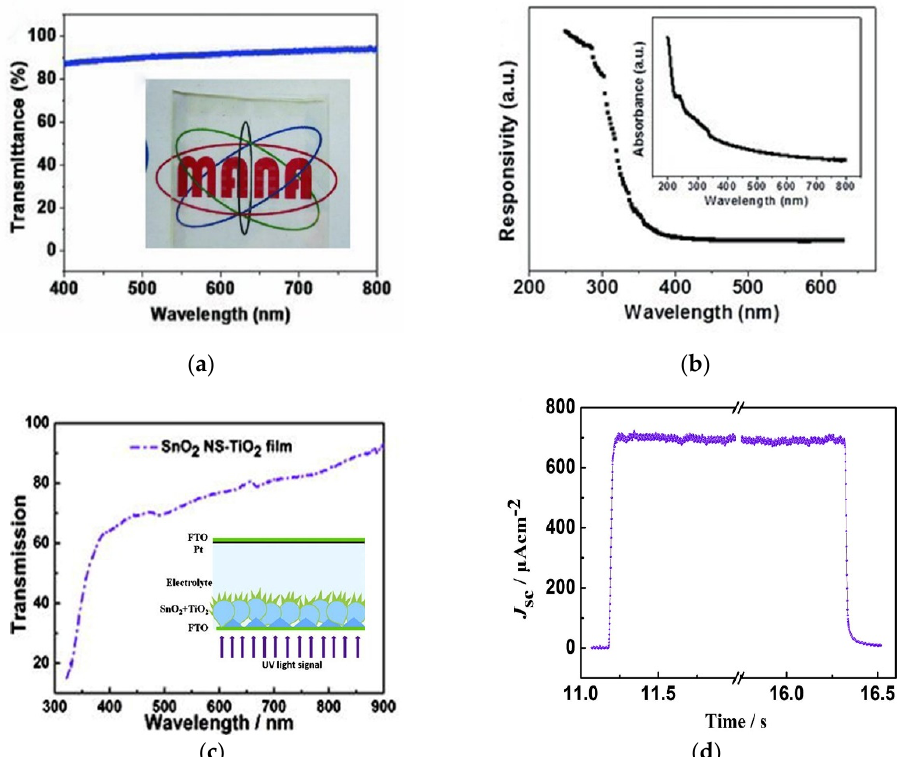
Figure 2. ( a ) Optical transmittance of the device in glass; ( b ) Spectroscopic photoresponse of the device measured at a bias of 5.0 V at different wavelengths ranging from 250 to 630 nm. The inset is optical absorption spectrum. Reproduced with permission from Ref. [49];2013, Wiley; ( c ) Schematic diagram of the structure of SnO 2 -TiO 2 photodetector; ( d ) Time response of SnO 2 -TiO 2 photodetector under 40 mW/cm 2 UV light (365 nm) illumination. Reproduced with permission from Ref. [56]; 2014, Elsevier.